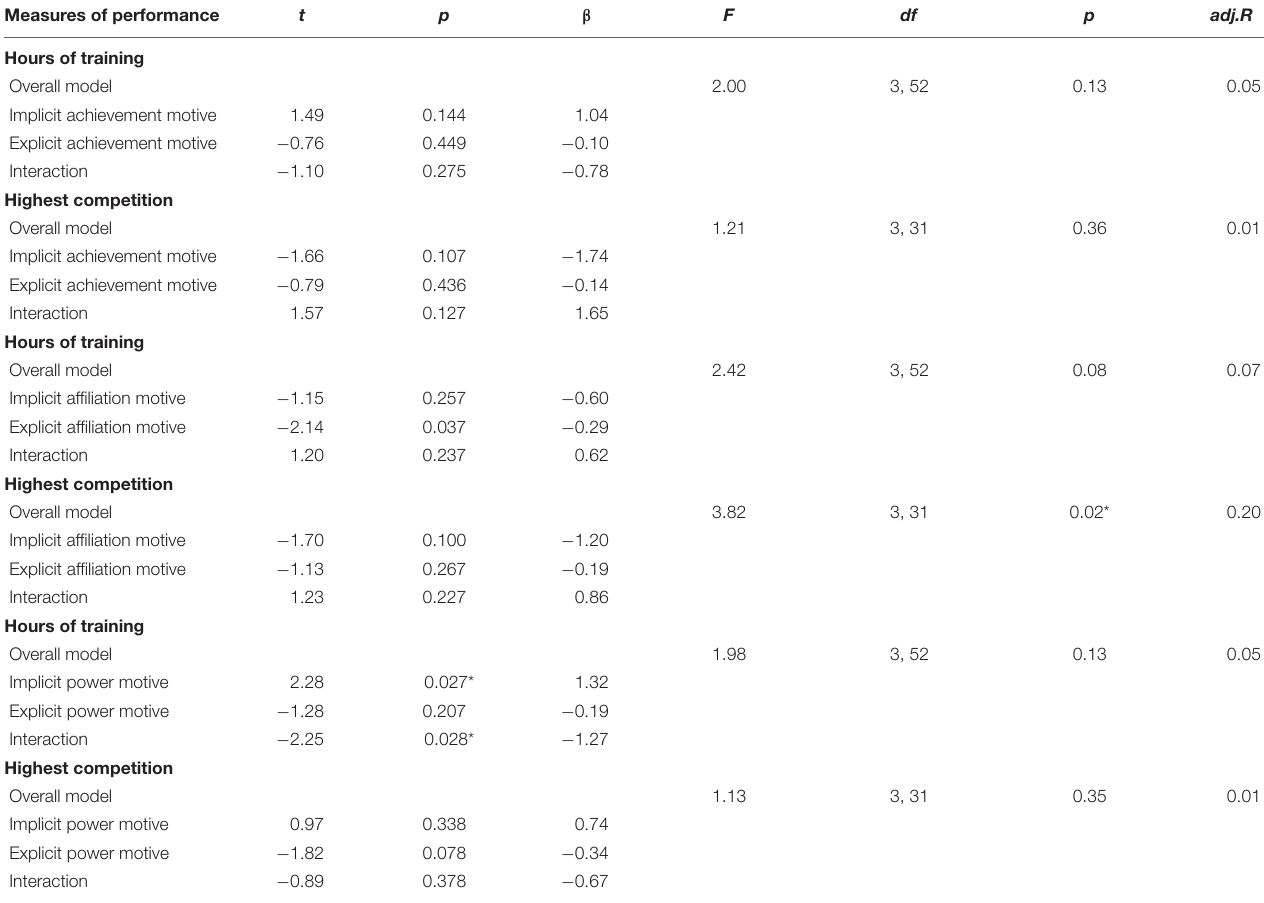
TABLE 2 | Regression analyses testing moderator effects of explicit motives on the association between implicit motives and sports performance